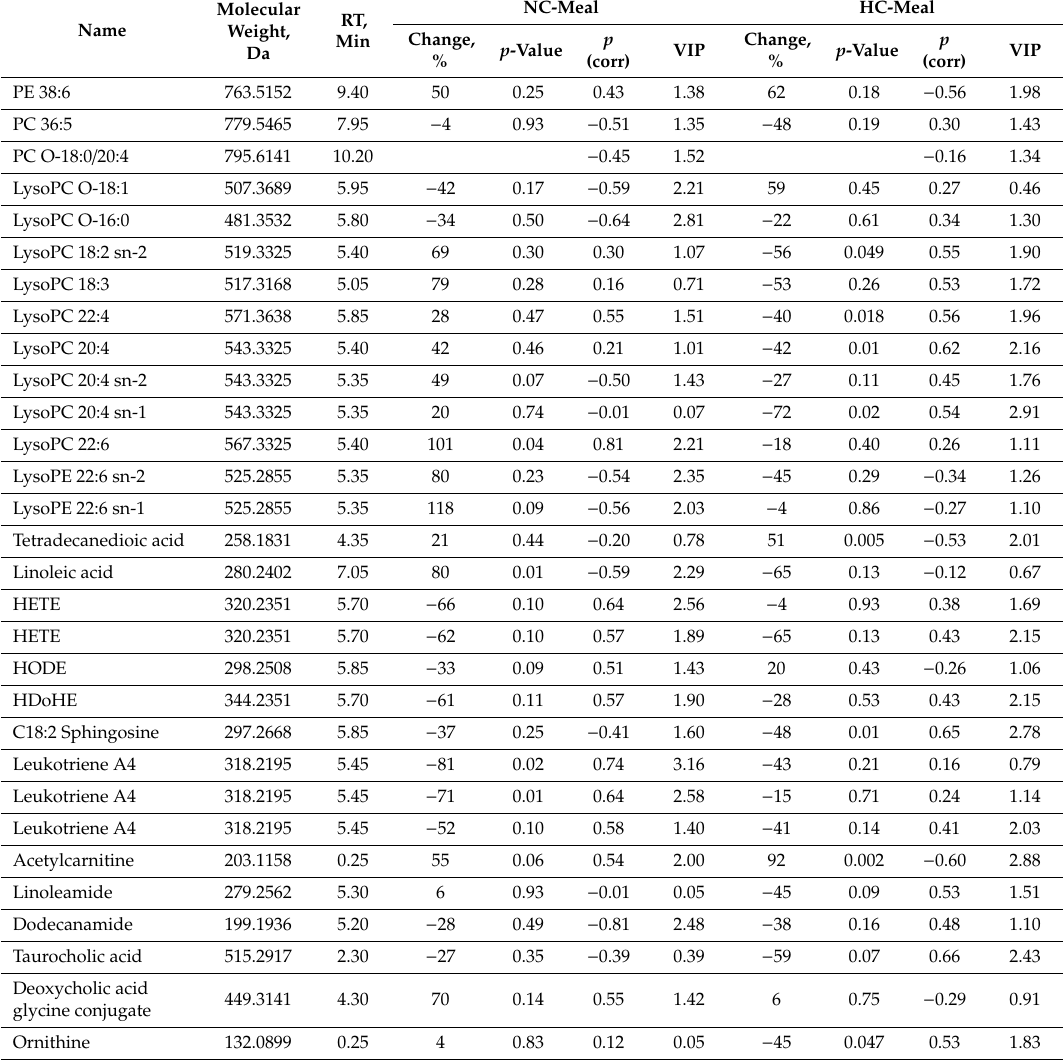
Table 2. The percentage di ff erences in AUCs of postprandial plasma metabolite levels after NC-meal and HC-meal intake in the PROX1 high-risk-genotype (CC) men compared to the low-risk genotype carriers (CT /